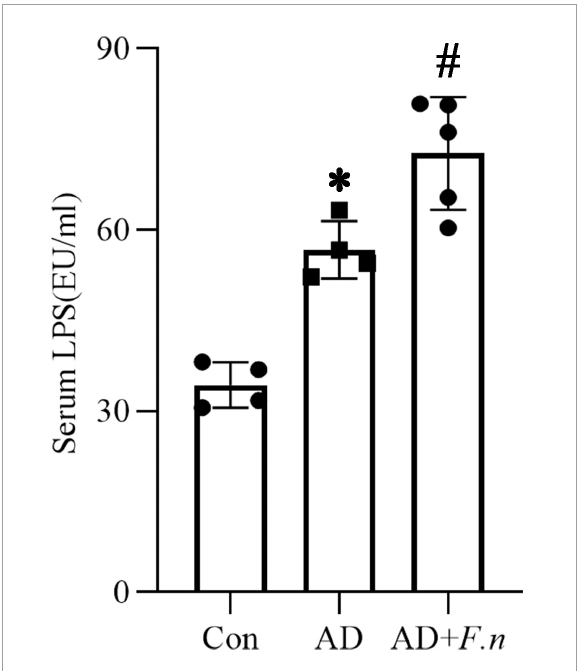
FIGURE4 Serum LPS. Limulus amebocyte lysate (LAL) assay detected the serum LPS in three groups, * P < 0.05 vs. Con group, # P < 0.05 vs. AD group, indicates statistically significant